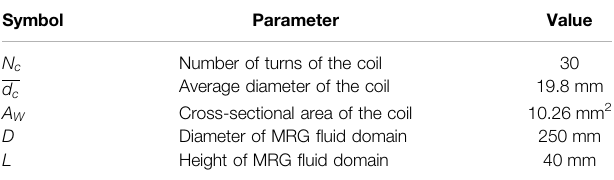
TABLE 1 | Parameters of heat transfer